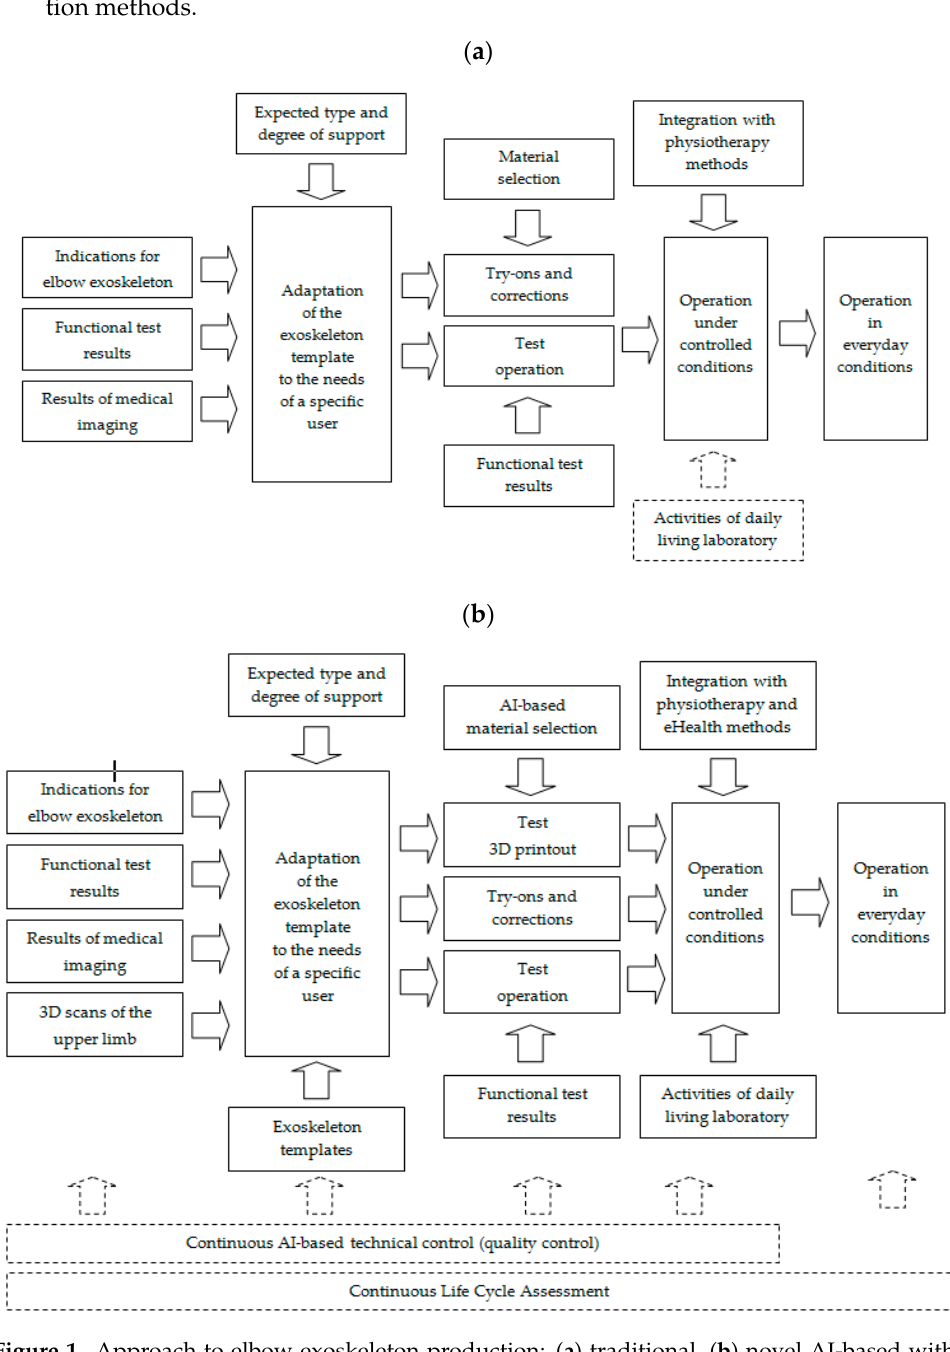
Figure 1. Approach to elbow exoskeleton production: ( a ) traditional, ( b ) novel AI-based within Industry 4.0 paradigm.